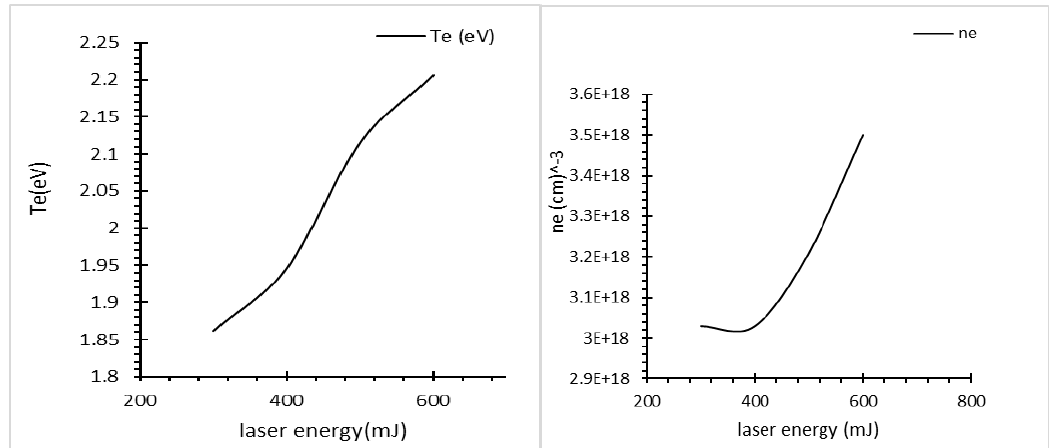
Figure 8: (T ) and (n ) against Laser Energy of the Indian costus Target. e e